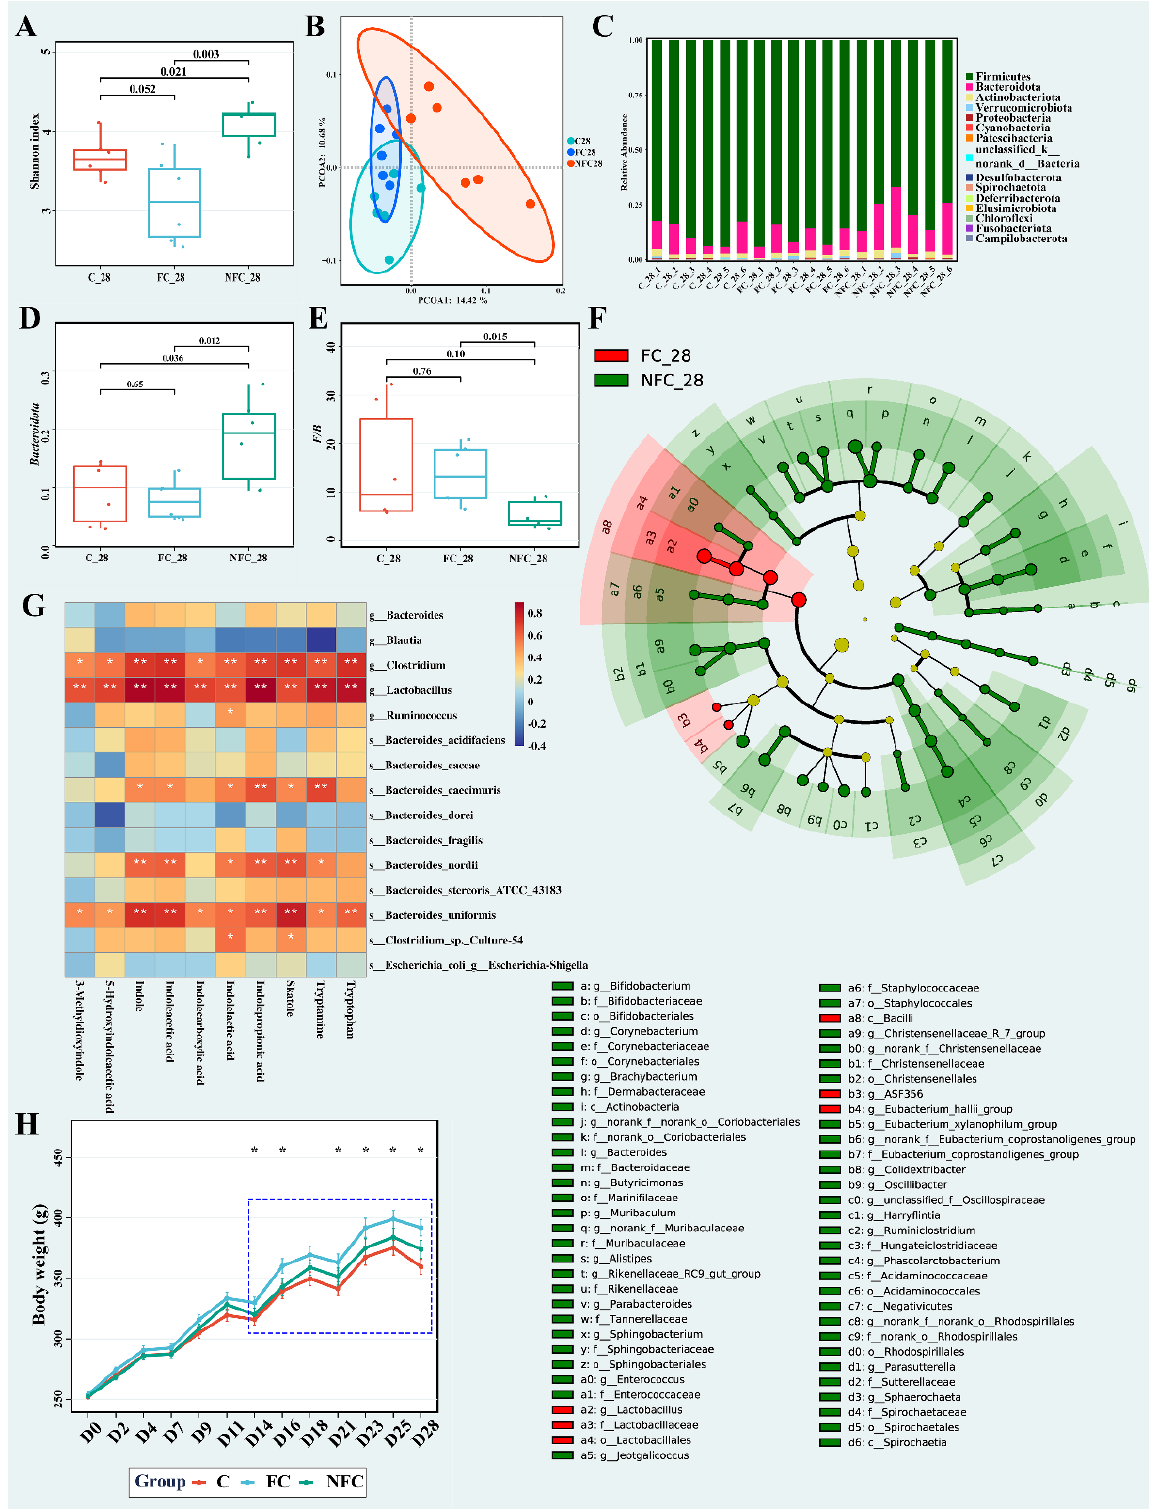
Figure 3. Effect of NFC and FC CAJs on rats: ( A ) Shannon index. ( B ) PCoA scores plot on OTU level. ( C ) Bar plot of gut microbiota on phylum level. ( D ) Box plot of Bacteroidota abundance. ( E ) Box plot of F / B ratio. ( F ) Cladogram from LEfSe analysis. ( G ) Correlation heatmap of microbiota and metabolites (The “*” means p < 0.05, and “**” means p < 0.01). ( H ) Body weight; * indicates significant difference ( p < 0.05) between FC and C